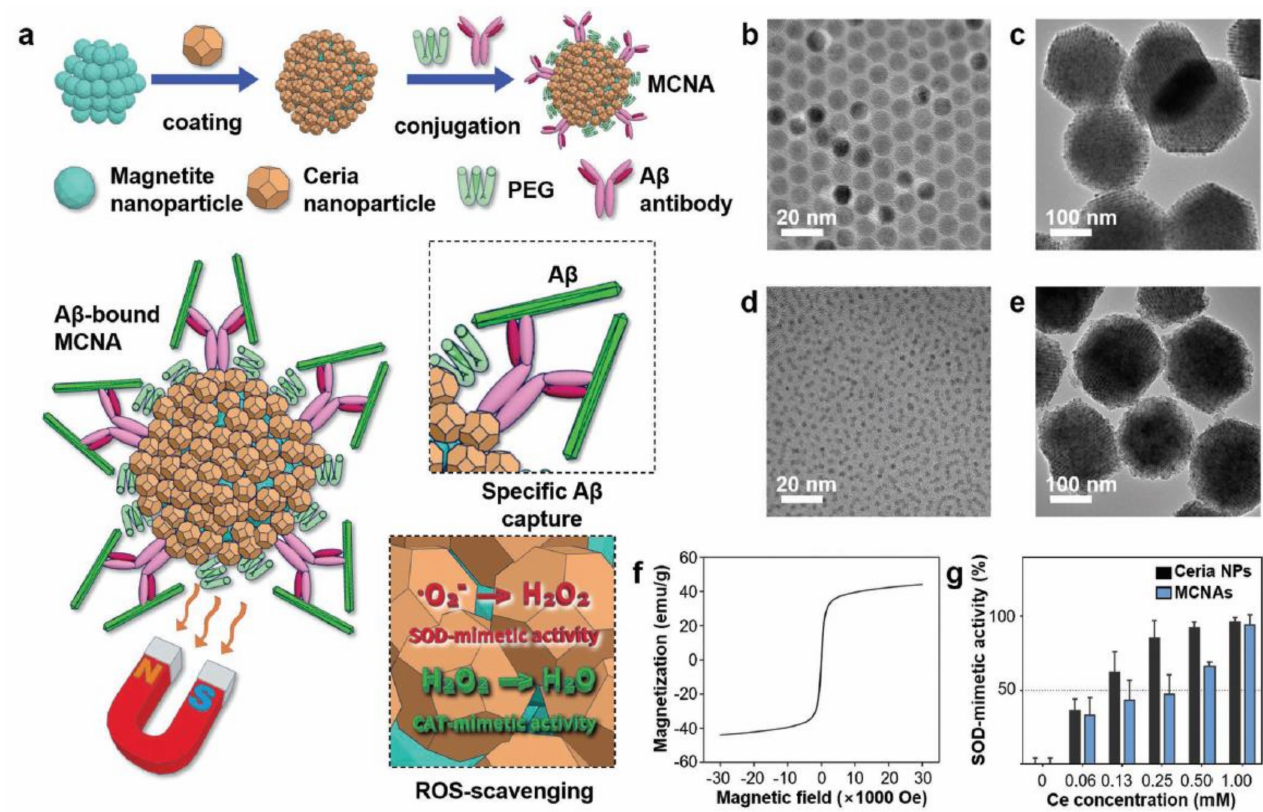
Figure 14. Magnetite/ceria NP assemblies (MCNAs). ( a ) Schematic preparation of MCNAs. ( b – e ) TEM images of magnetite NPs ( b ), their assemblies ( c ), ceria NPs ( d ), and MCNAs ( e ). ( f ) Magnetization curve of MCNAs. ( g ) SOD-mimetic activity of MCNAs. Reproduced with permission from [211], Copyright © 2021 WILEY-VCH Verlag GmbH & Co. KGaA,